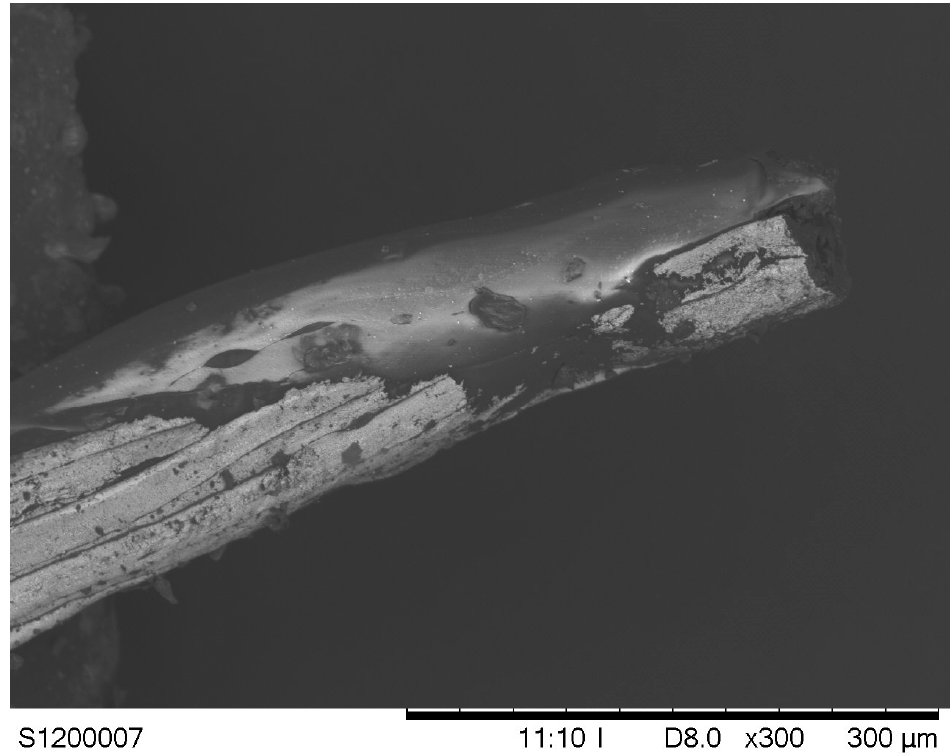
Figure 8. SEM image of the failed Silver-Tech 120 specimen, where the individual fibers have molten together.